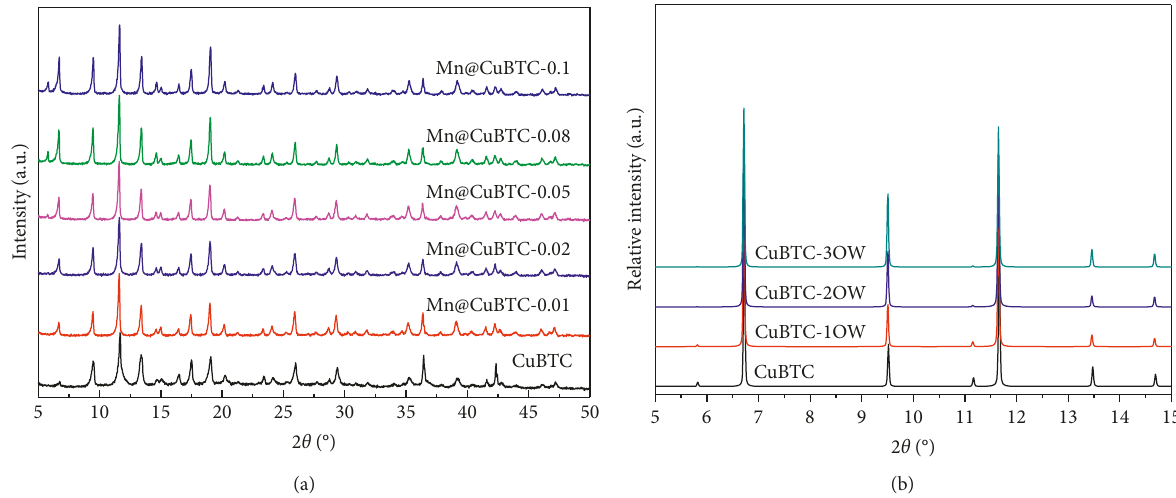
Figure 2: XRD profiles of (a) experimental results obtained from CuBTC and Mn@CuBTC-X in this study; (b) simulated CuBTC with different amount of water presented in three sites in the framework (based on the structural parameters reported in [27]).